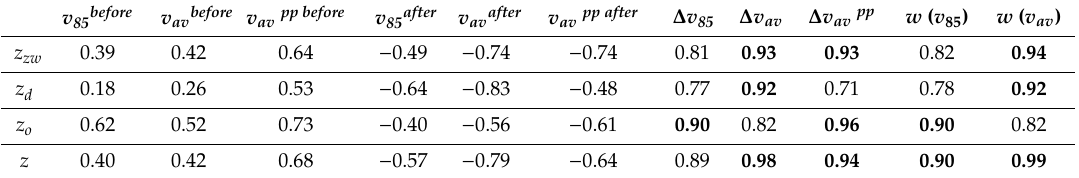
Table 3. Coe ffi cients of correlation R between the quantitative measures and the chosen speed distribution parameters (excluding additional sections where chicanes were not installed).